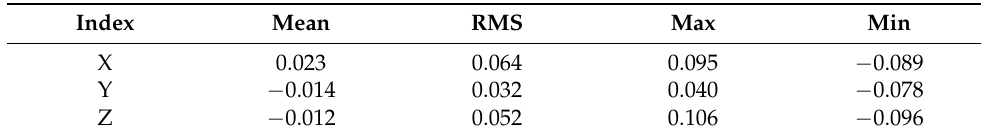
Table 5. Ground coordinates differences statistics of ZY-3 three-line array camera corresponding image points after geometric calibration. (Unit: meter).